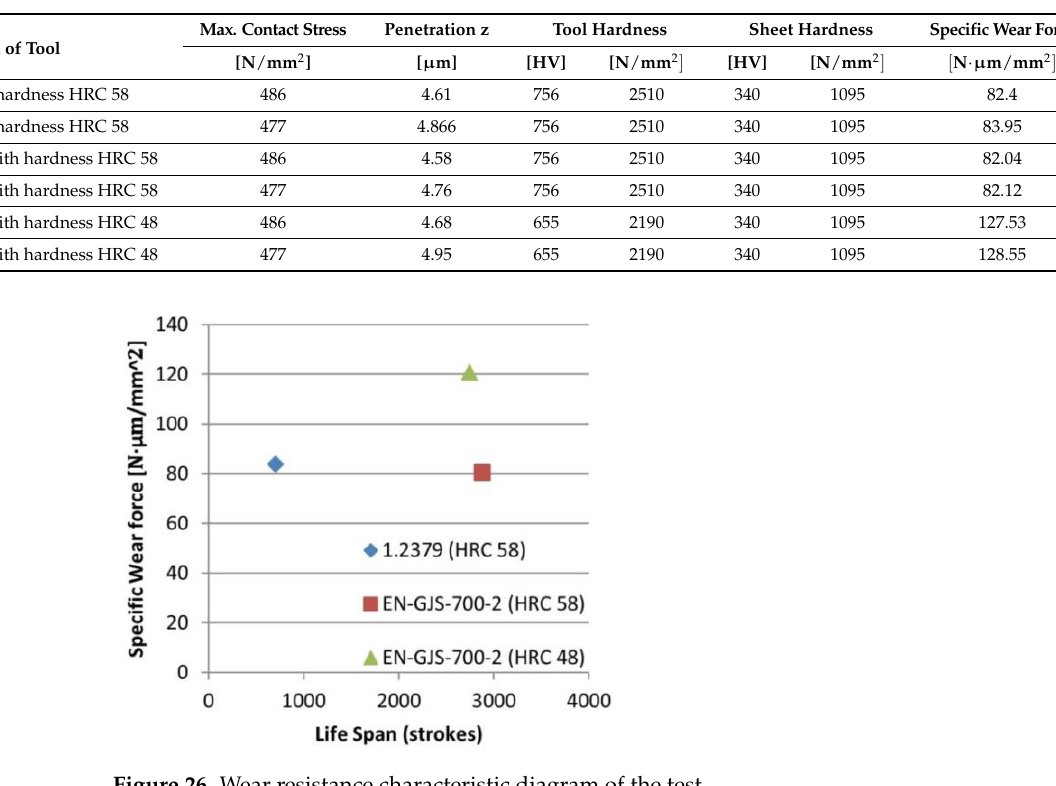
Table 6. Calculated parameters and specific wear force for wear resistance characterizing.